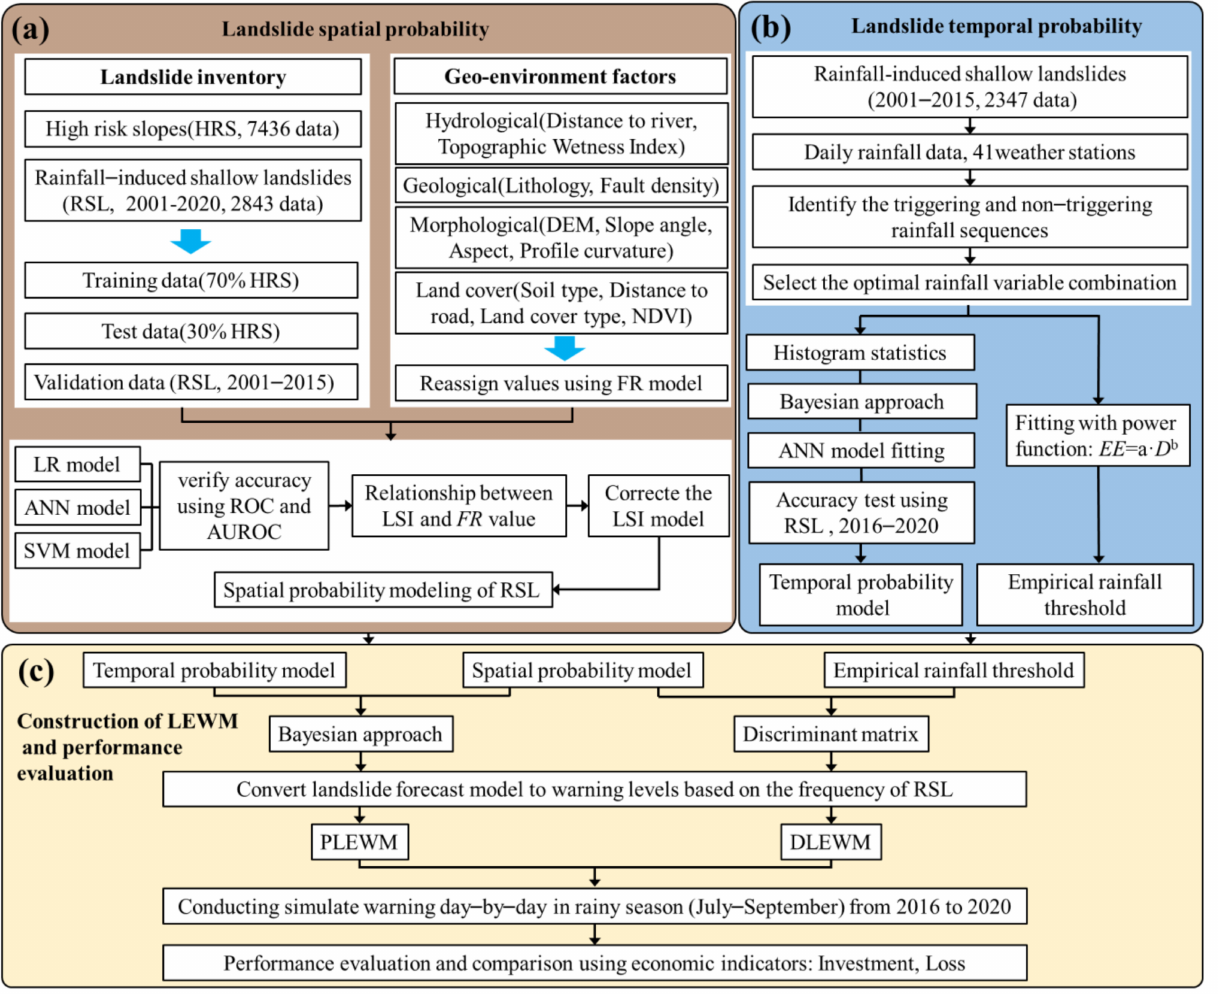
Figure 1. Flowchart of the